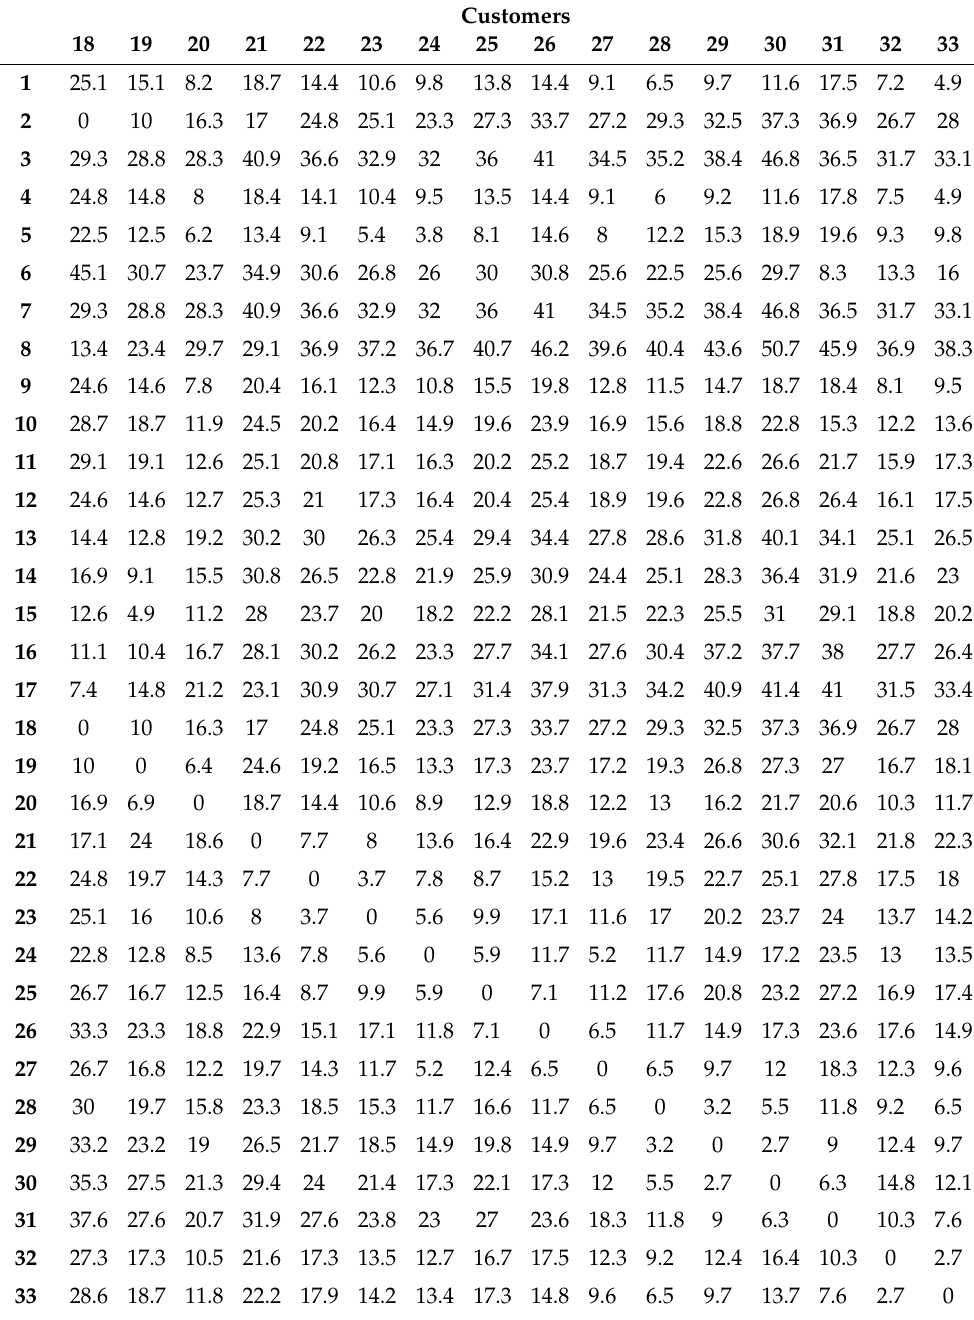
Table A2. Distance matrix for exemplary study—part 2—destination points